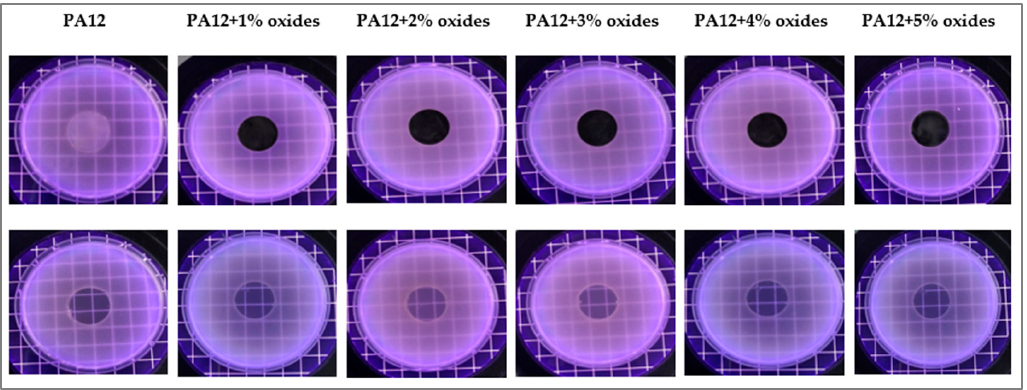
Figure A3. Comparison of E. coli growth in contact with PA12 and PA12 + 1–5 wt % oxides.